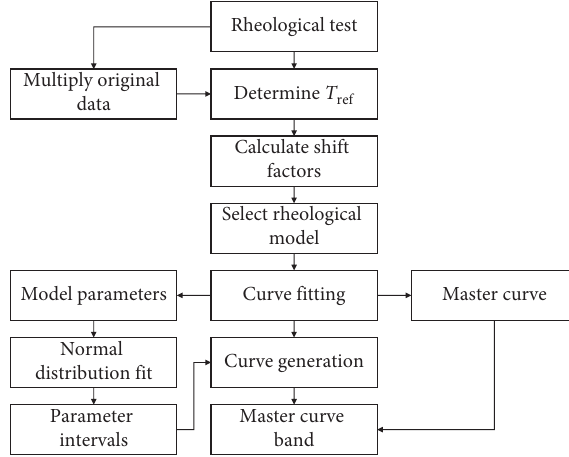
Figure 3: Schematic of master-curve band